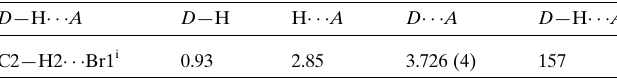
Table 1 Hydrogen-bond geometry (A˚ , (cid:2) ).